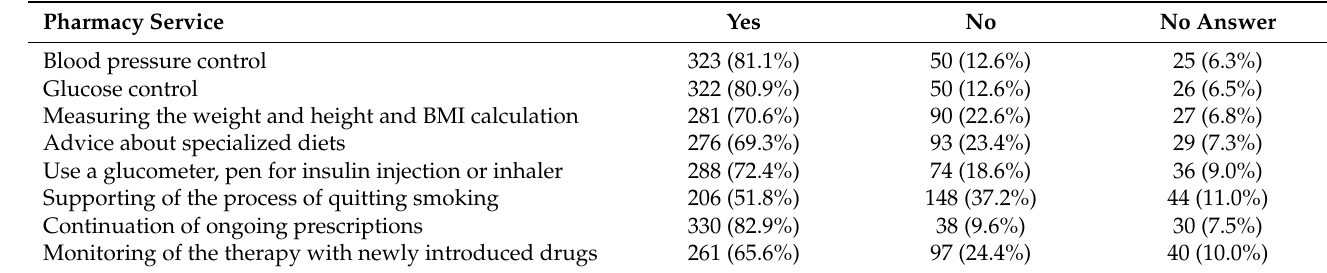
Table 5. Attitude of respondents to the expansion of different pharmacy